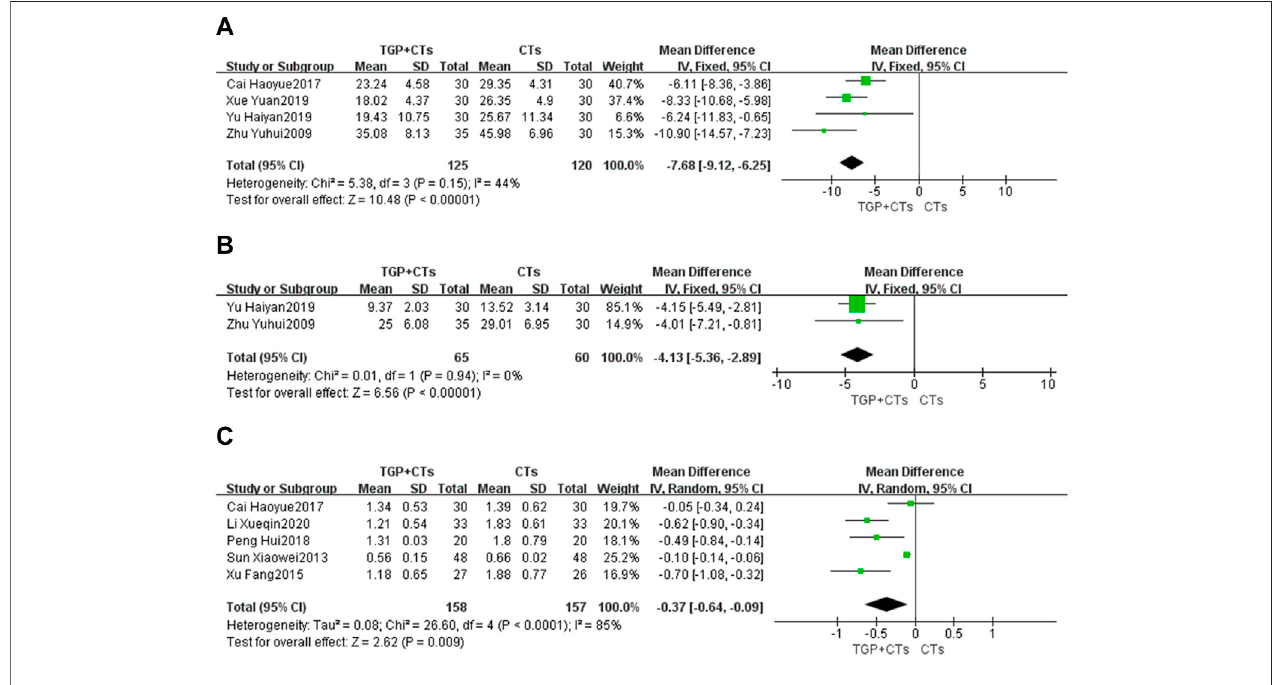
FIGURE 5 | Forest plot of ESR (A) , CRP (B) and 24-h urine protein (C) .